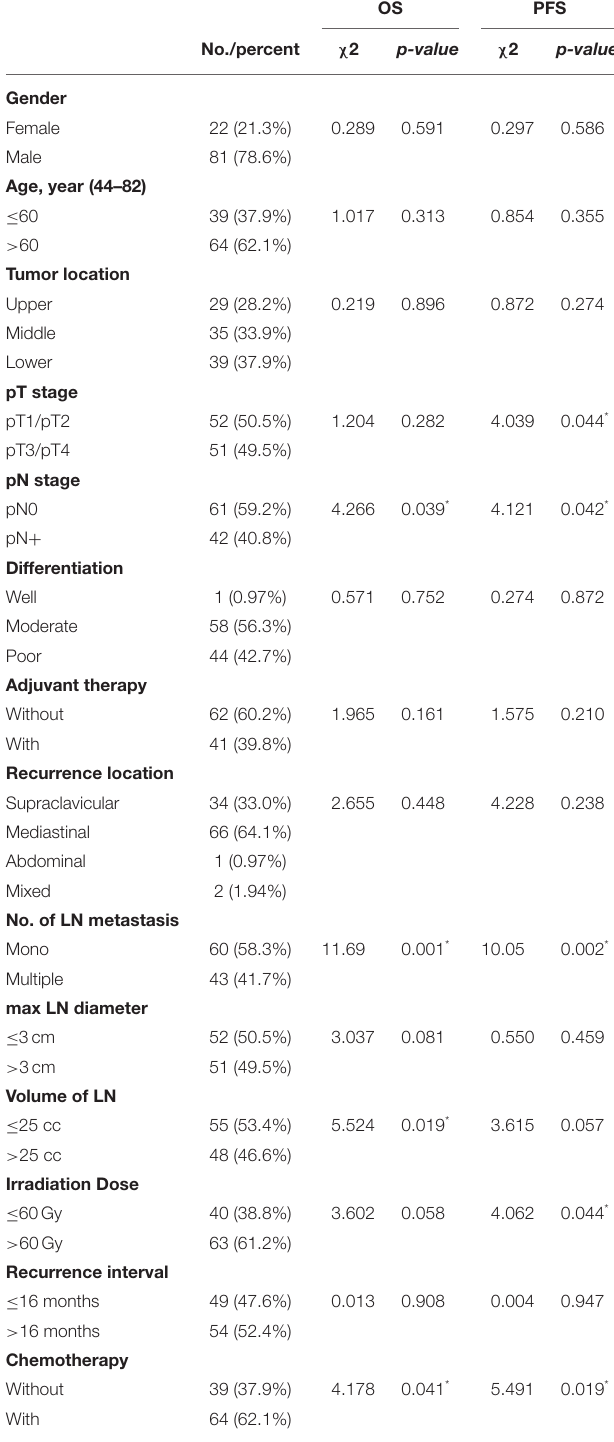
TABLE 1 | Baseline characteristics and univariate analyses for overall survival and progression free